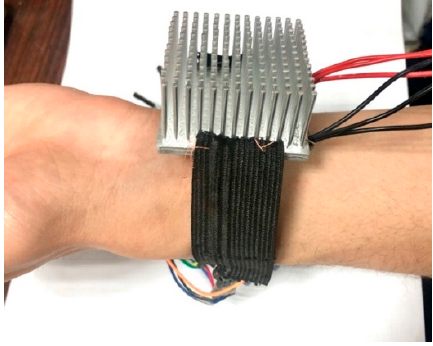
Figure 9. Human wrist based system test.